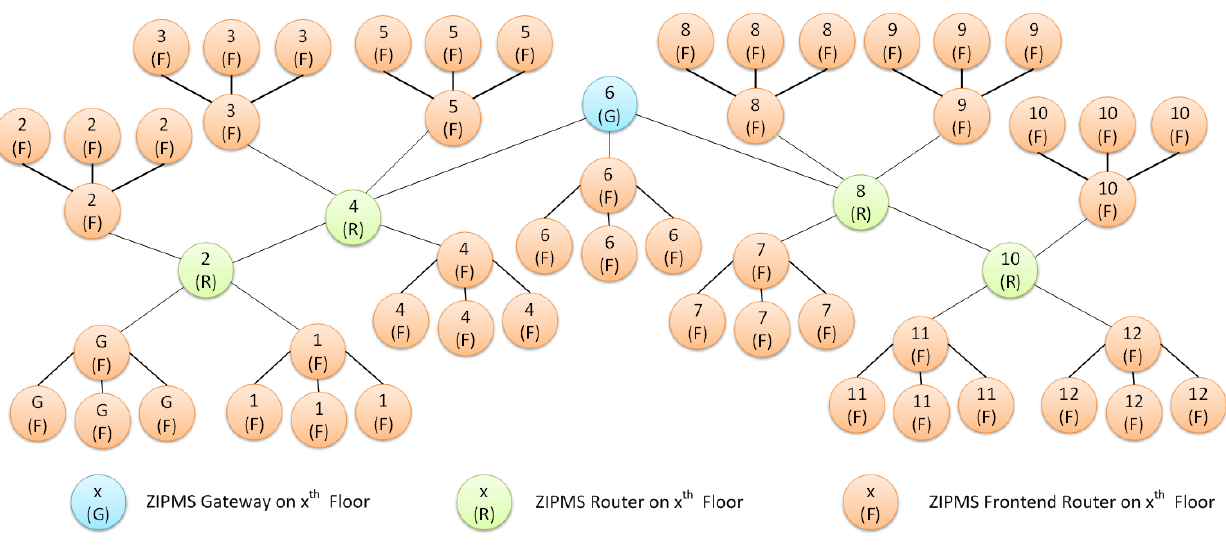
Figure 6. ZIPMS tree network.